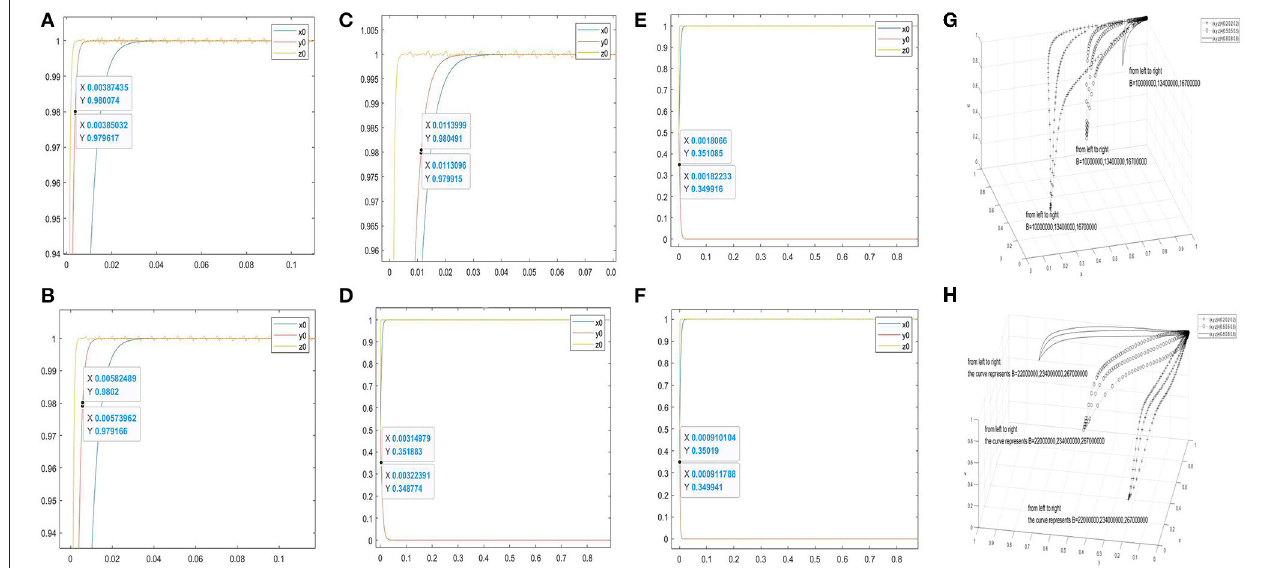
FIGURE 5 | Evolutionary simulation results of the parameter B . (A–C) the value range of the abscissa when the ordinate is 0.98 under different factors. (D–F) the value range of the abscissa when the ordinate is 0.35 under different factors. (H,G) the three-dimensional comparison diagrams under the three-way selection ratio.